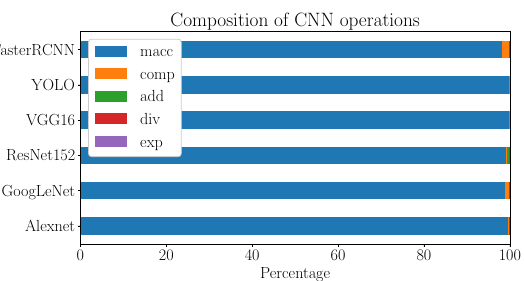
Figure 1. Percentage of Multiply and ACcumulate (MAC), comparison (comp), addition (add), division (div) and exponent (exp) operations for different